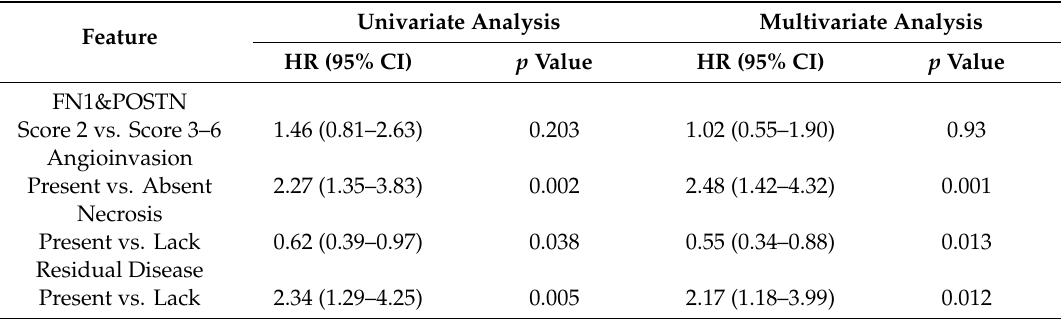
Table 4. Univariate and multivariate analysis of disease-free